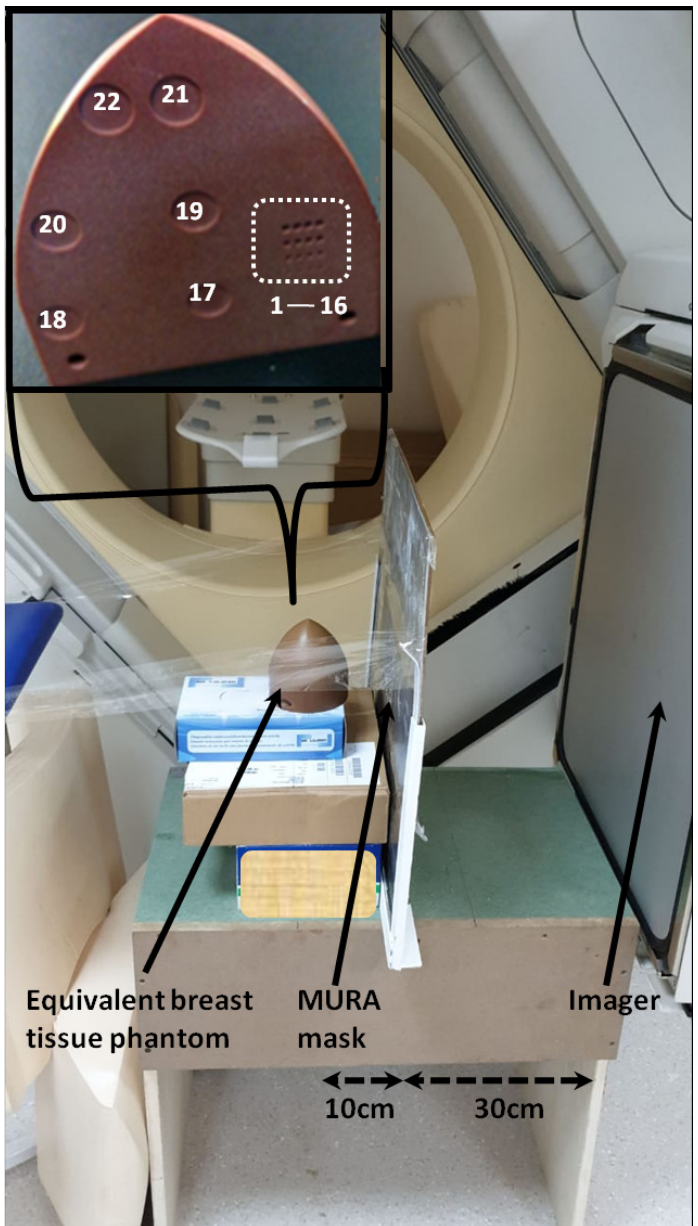
Figure 1. Experimental setup including equivalent tissue anthropomorphic breast phantom, MURA mask and imager. Twenty-two possible locations for the inserted 99 m Tc were also given. Additionally, as seen in Figure 1, the phantom includes 22 possible locations (with the same thicknesses of 0.1 cm) for tumor positioning. Locations from 17 to 22 have the same radius of 1.2 cm; however, the other 16 options have different radii from 0.1 to 0.25 cm. All locations were cylindrical and filled with air as the medium. On the other hand, the MURA mask consists of a 41 × 41 array pattern. Designed at the center of a thin sheet holder of lead with the dimension of 60 × 60 × 0.15 cm 3 , the mask was formed with a given distribution of box-shaped holes (0.2 × 0.2 × 0.15 cm 3 ), resulting in a global dedicated volume of 8.2 × 8.2 × 0.15 cm 3 . Similar to the desired mask, as described in the literature, it contains 50% open/close area, i.e., the same surface area of gamma ray-opaque and gamma-ray- transparent zones. A more detailed description was given by Kadri et al. [11]. Moreover, the detection system consists of the NaI(Tl) crystal detector with a surface of 0.597 × 0.597 cm 2 and a thickness of 0.95 cm. The detector was pixelated onto 512 × 512 scoring